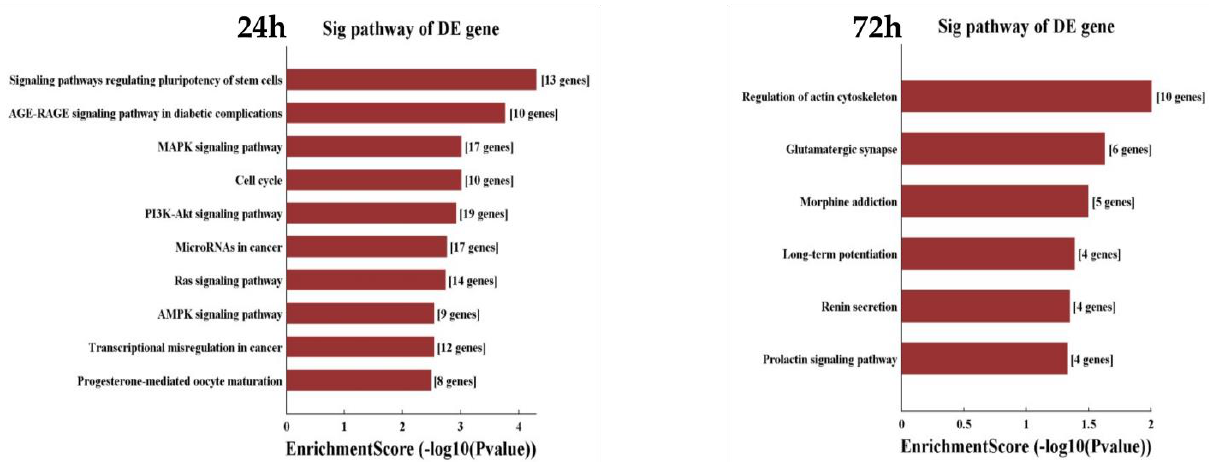
Figure 8. Enrichment score values of the top 10 enrichment pathways following SARS-CoV-2 infection vs. Mock. The bar plot shows the top 10 significantly enriched KEGG pathways of genes targeted by ( A ) upregulated and ( B ) downregulated miRNAs at 24 h and 72 h post-infection.